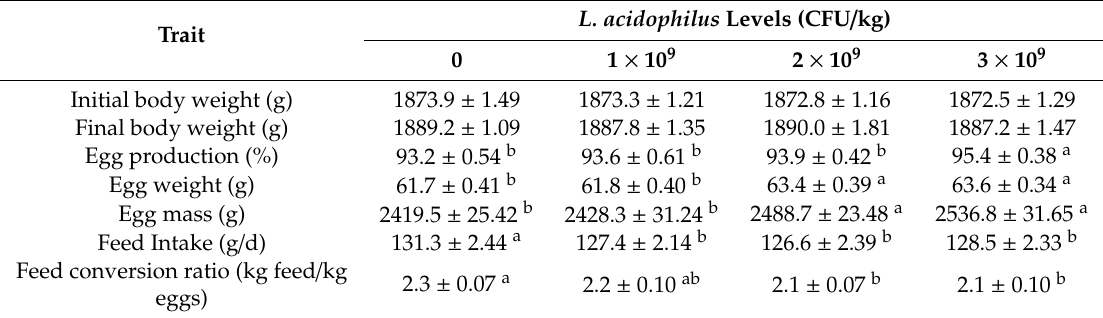
Table 4. E ff ect of dietary Lactobacillus acidophilus supplementation on productive performance of laying